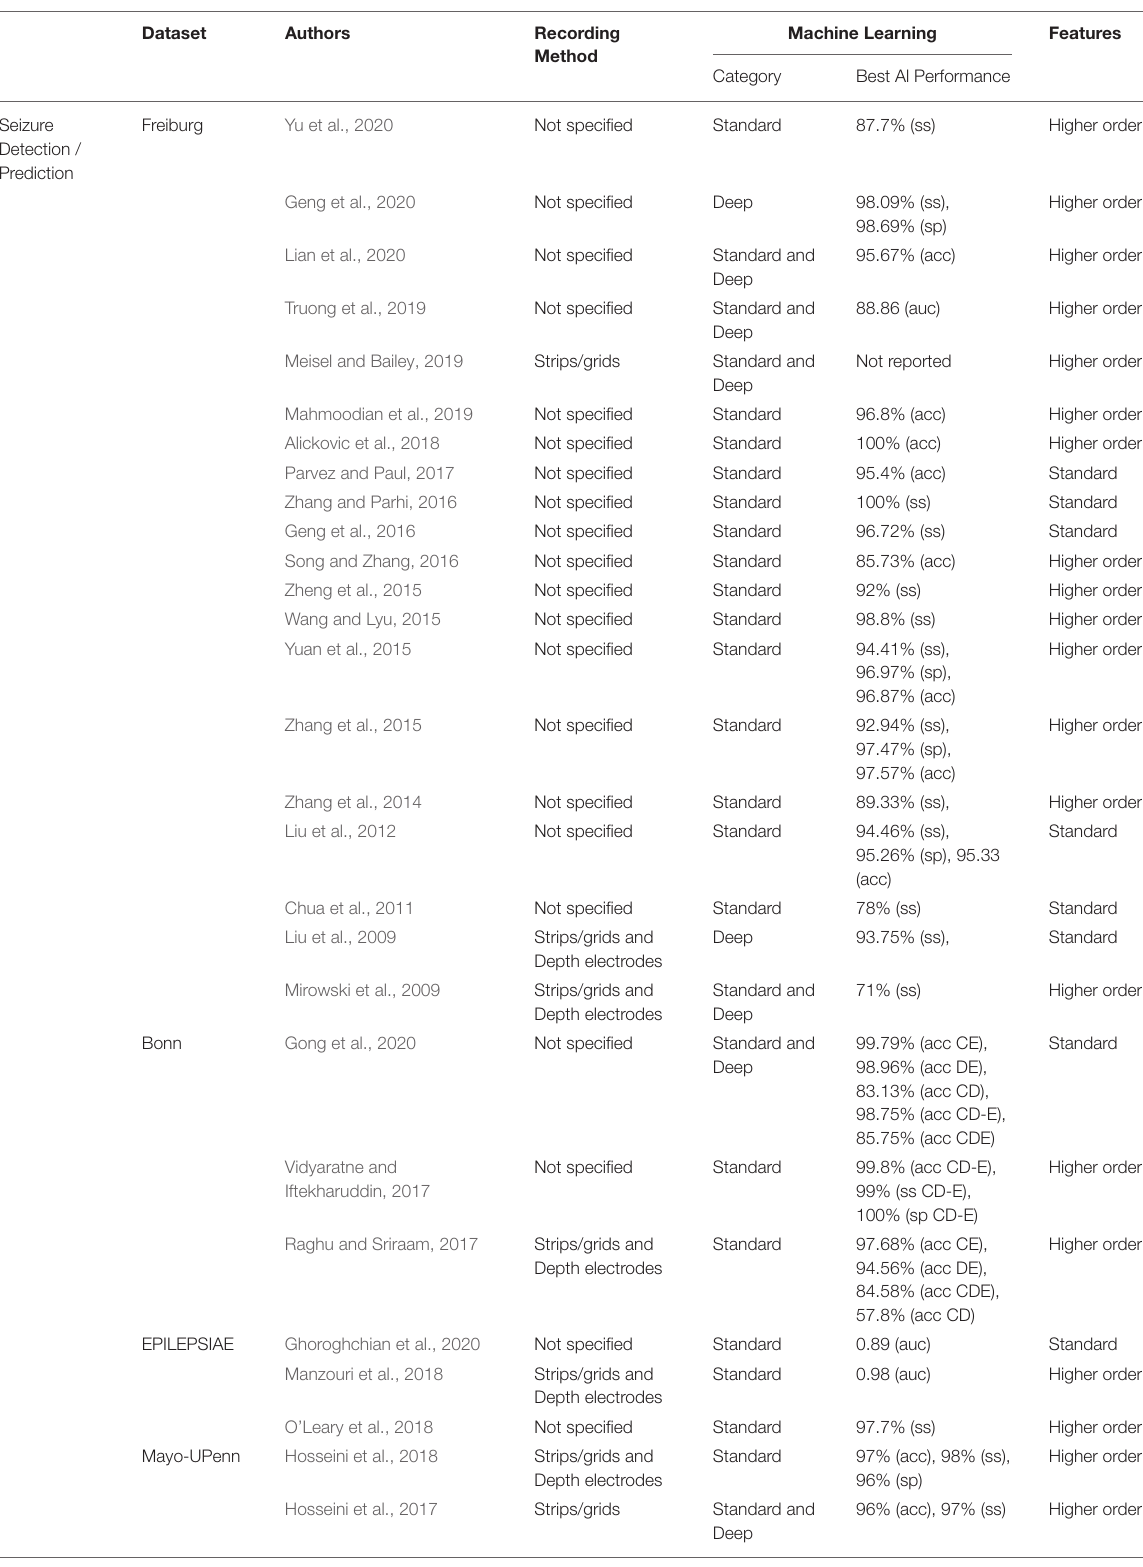
TABLE 1 | Summary of literature on artificial intelligence in intracranial